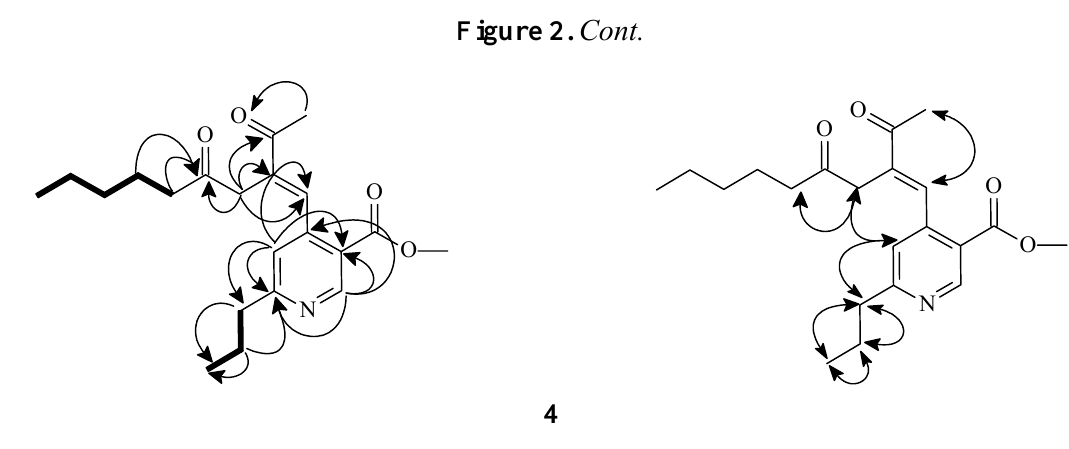
Table 2. 1 H- (400 MHz) and 13 C-NMR (100 MHz) data of 3 and 4 in CDCl